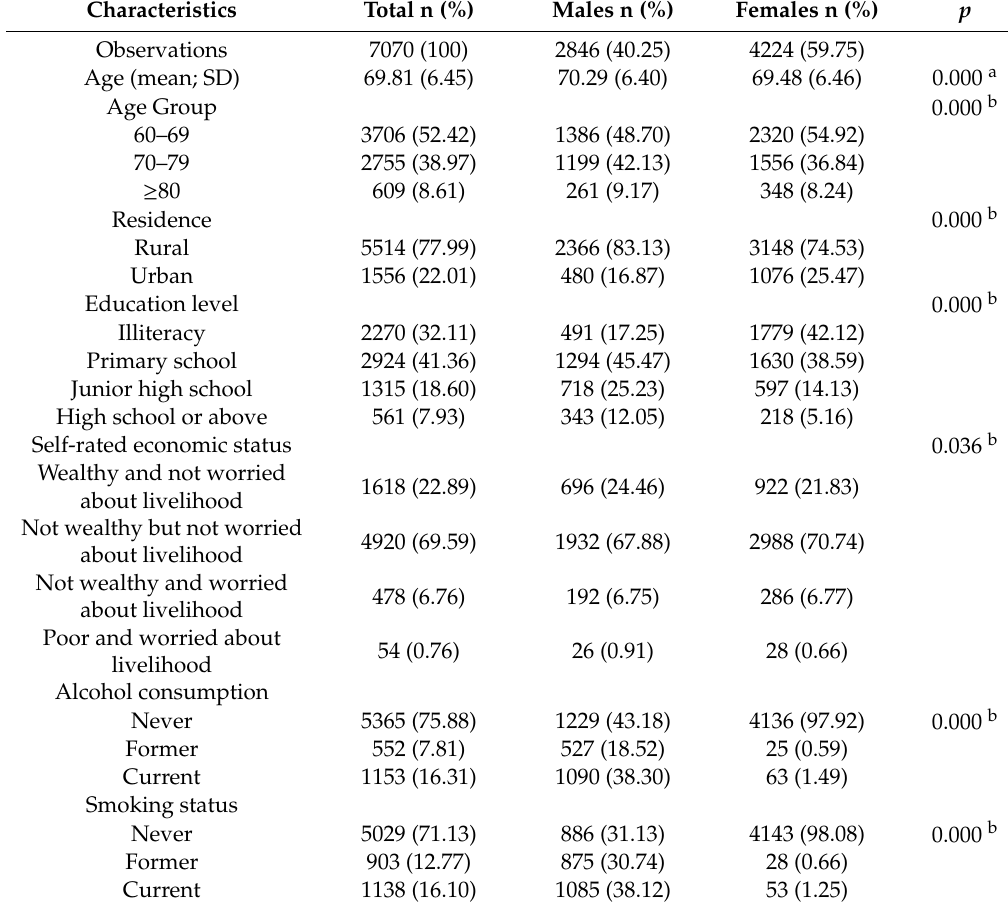
Table 1. Descriptive characteristics of study participants by gender